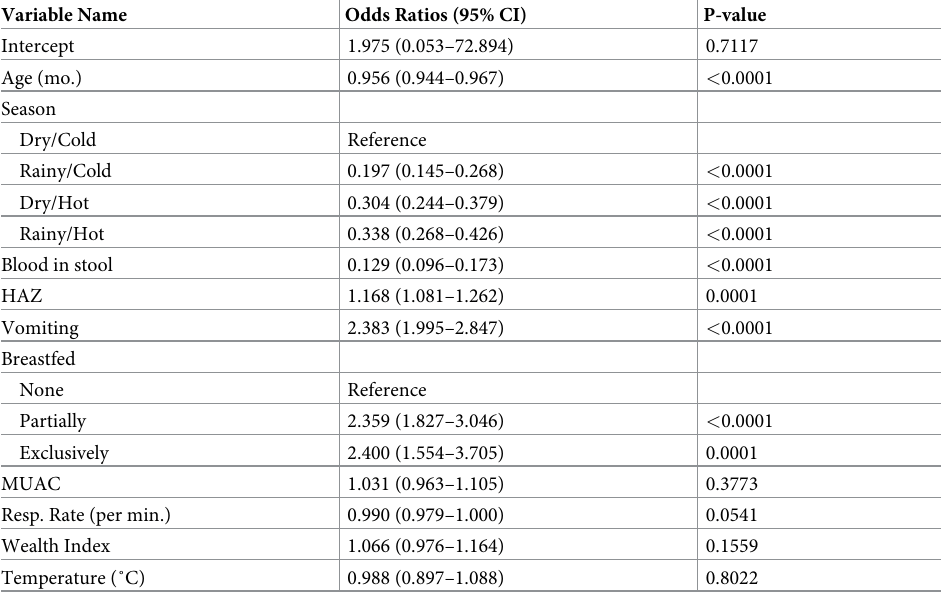
Table 3. The odds ratios, 95% confidence interval, and p-value from a logistic regression model for the viral only